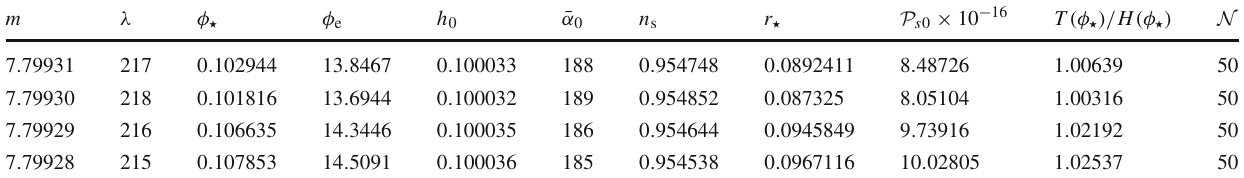
Table 3 The estimations of the free parameters of the non-comoving warm inflationary model in the strong dissipation regime with power- law scale factor by using the Planck 2013, 2015 and 2018 data sets, and for C γ = 50. We have restricted our analysis to real values of the scalar